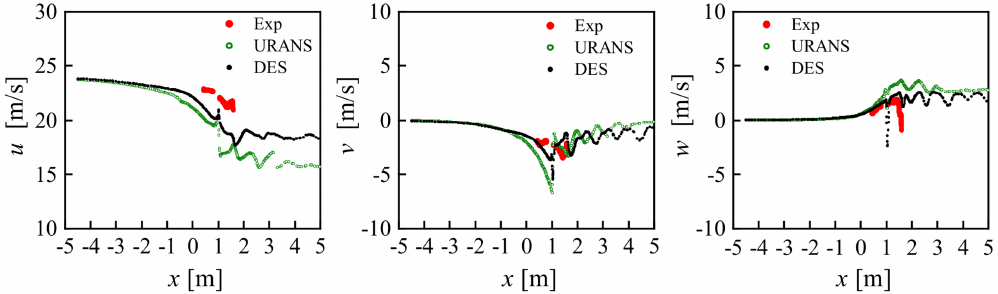
Figure 25. Axial profile of velocity components at y = − 1.5 m under wind speed of 24 m/s, TSR =